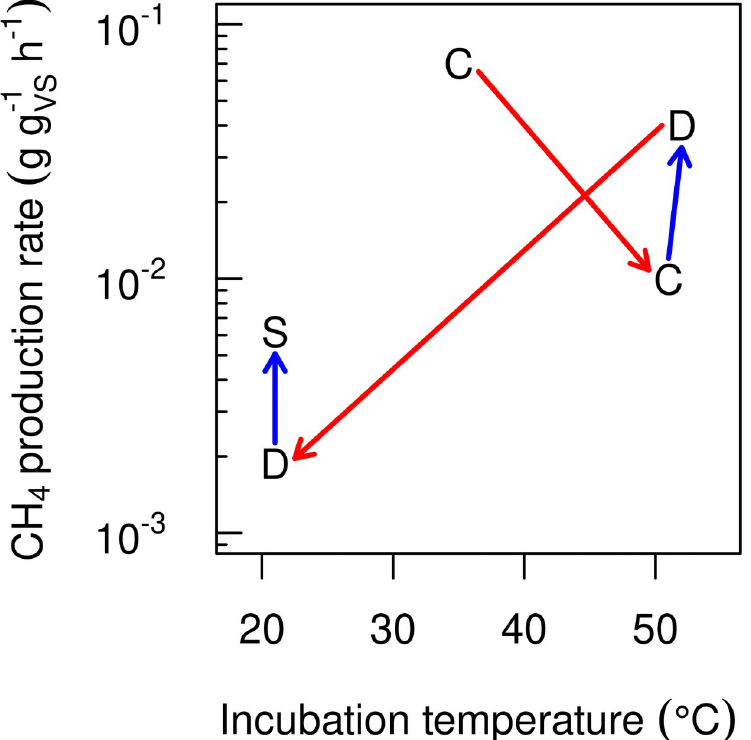
Fig 1. Example of short- and long-term responses of methane production to temperature change. Differences between short- and long-term response to temperature change measured by Elsgaard et al. [22]. Labels identify source: C = cattle manure (from barn), D = fresh digestate (directly from anaerobic digester), S = stored ( > 1 month) digestate. Red arrows show short-term effects (differences between samples from the same source when incubated for 17 hours), and blue arrows apparent long-term effects (differences for samples stored for short and long time (weeks or months) at the same temperature)).